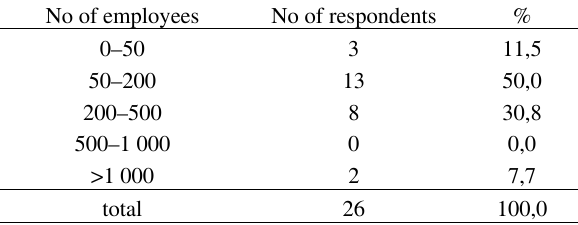
Table 2 . Number of employees of the participating